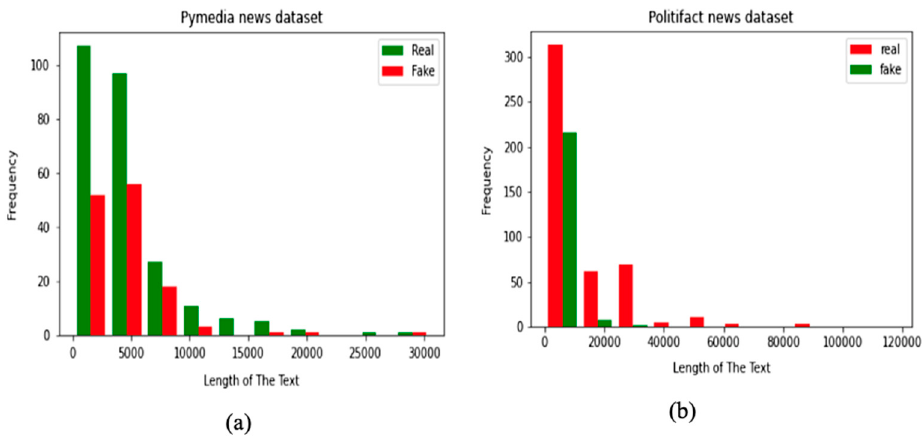
Figure 4. ( a ) Pymedia news dataset frequency distribution. ( b ) PolitiFact news dataset frequency distribution.